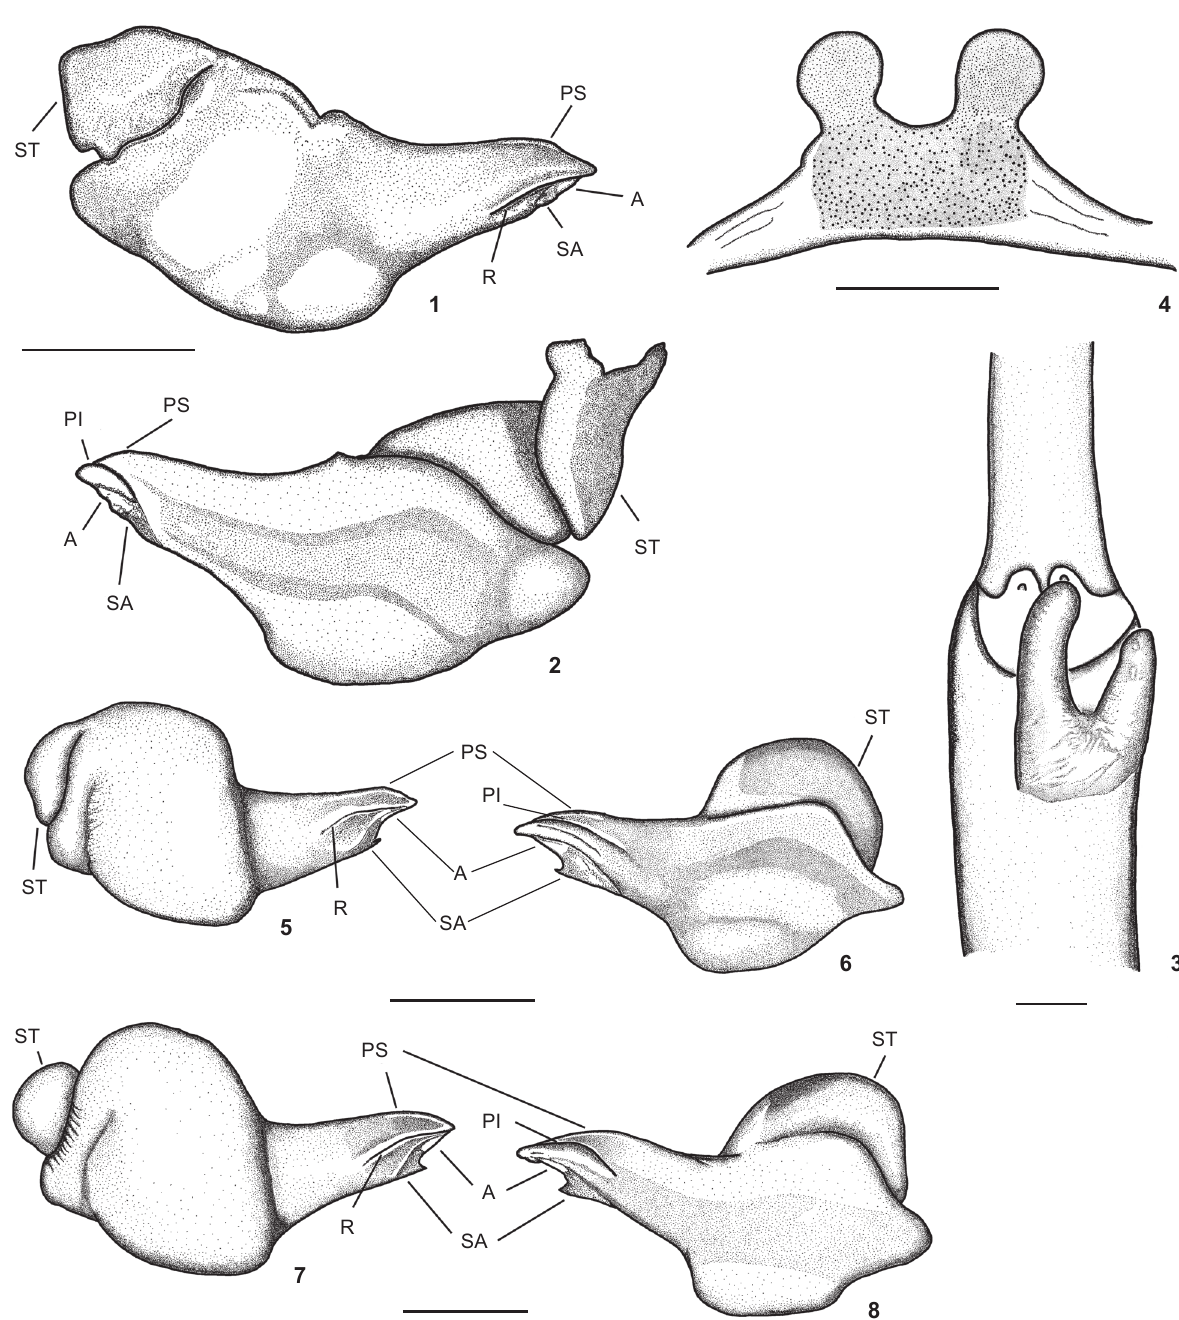
Figures 1-8. Vitalius nondescriptus comb. nov. (1-3) Holotype male: (1) right palpal bulb, retrolateral view; (2) right palpal bulb, prolateral view; (3) right leg I bifid tibial spur, ventral view. 4. Female MZSP 465351: spermathecae, dorsal view; (5-8) palpal bulb variation. (5-8) Male MZSP 465161: (5) right palpal bulb, retrolateral view; (6) right palpal bulb, prolateral view. 7-8. Male MZSP 465171: (7) right palpal bulb, retrolateral view; (8) right palpal bulb, prolateral view. Both from Ouro Preto, state of Minas Gerais, Brazil (captive born from female MZSP 465351). (A) Apical keel, (PI) prolateral inferior keel, (PS) prolateral superior keel, (SA) subapical keel, (ST) subtegulum. Scale bars = 1